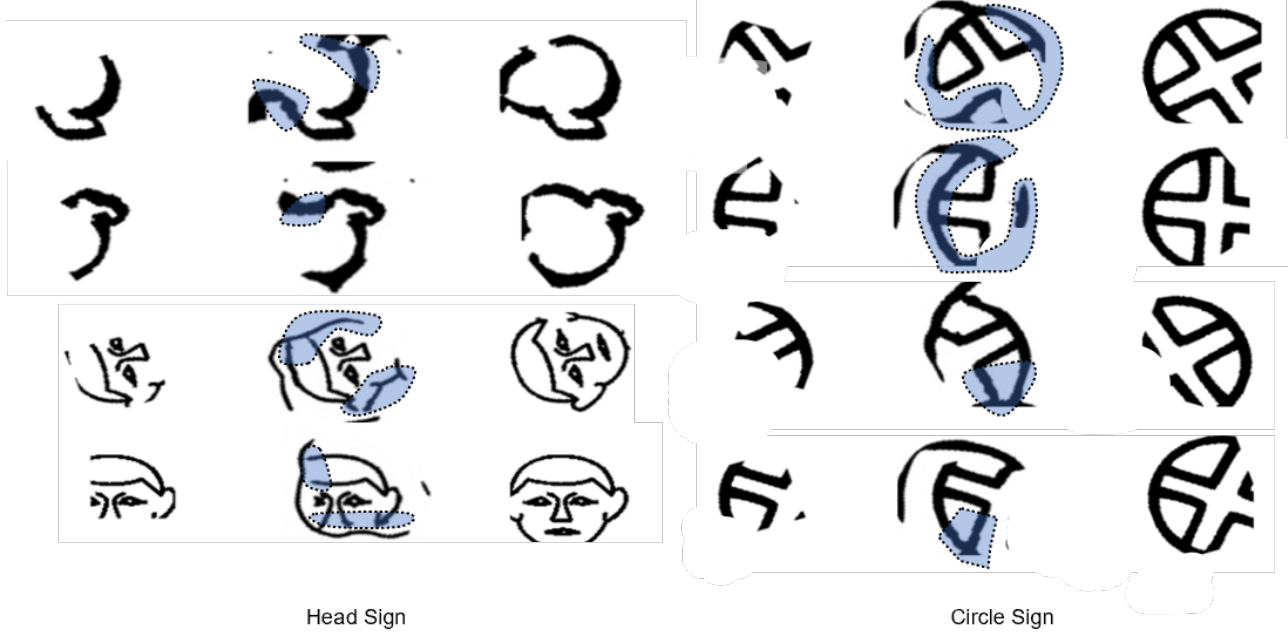
Figure 20. Examples of decoration completions for the head and circle inscription. The delineated areas correspond to correct predictions. Although the general inscription is distorted, the correct segments might support semi-automatic registration